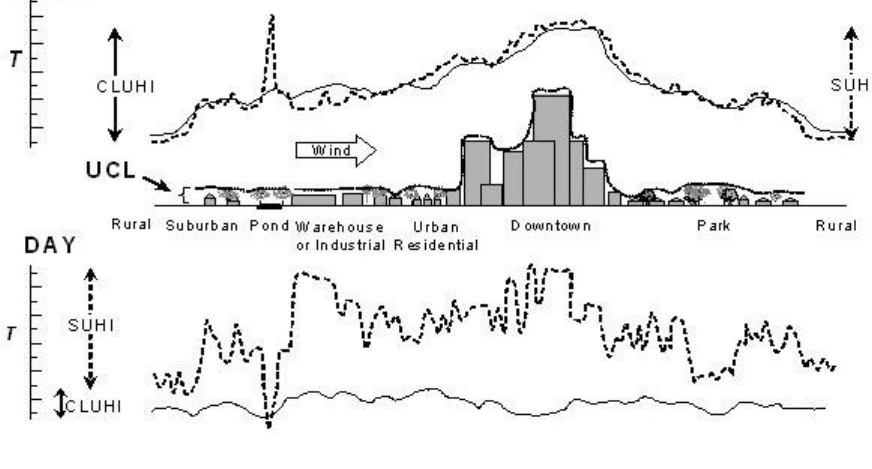
Figure 2. Theoretical magnitude of an urban heat island (UHI) on a city section adopted from Voogt